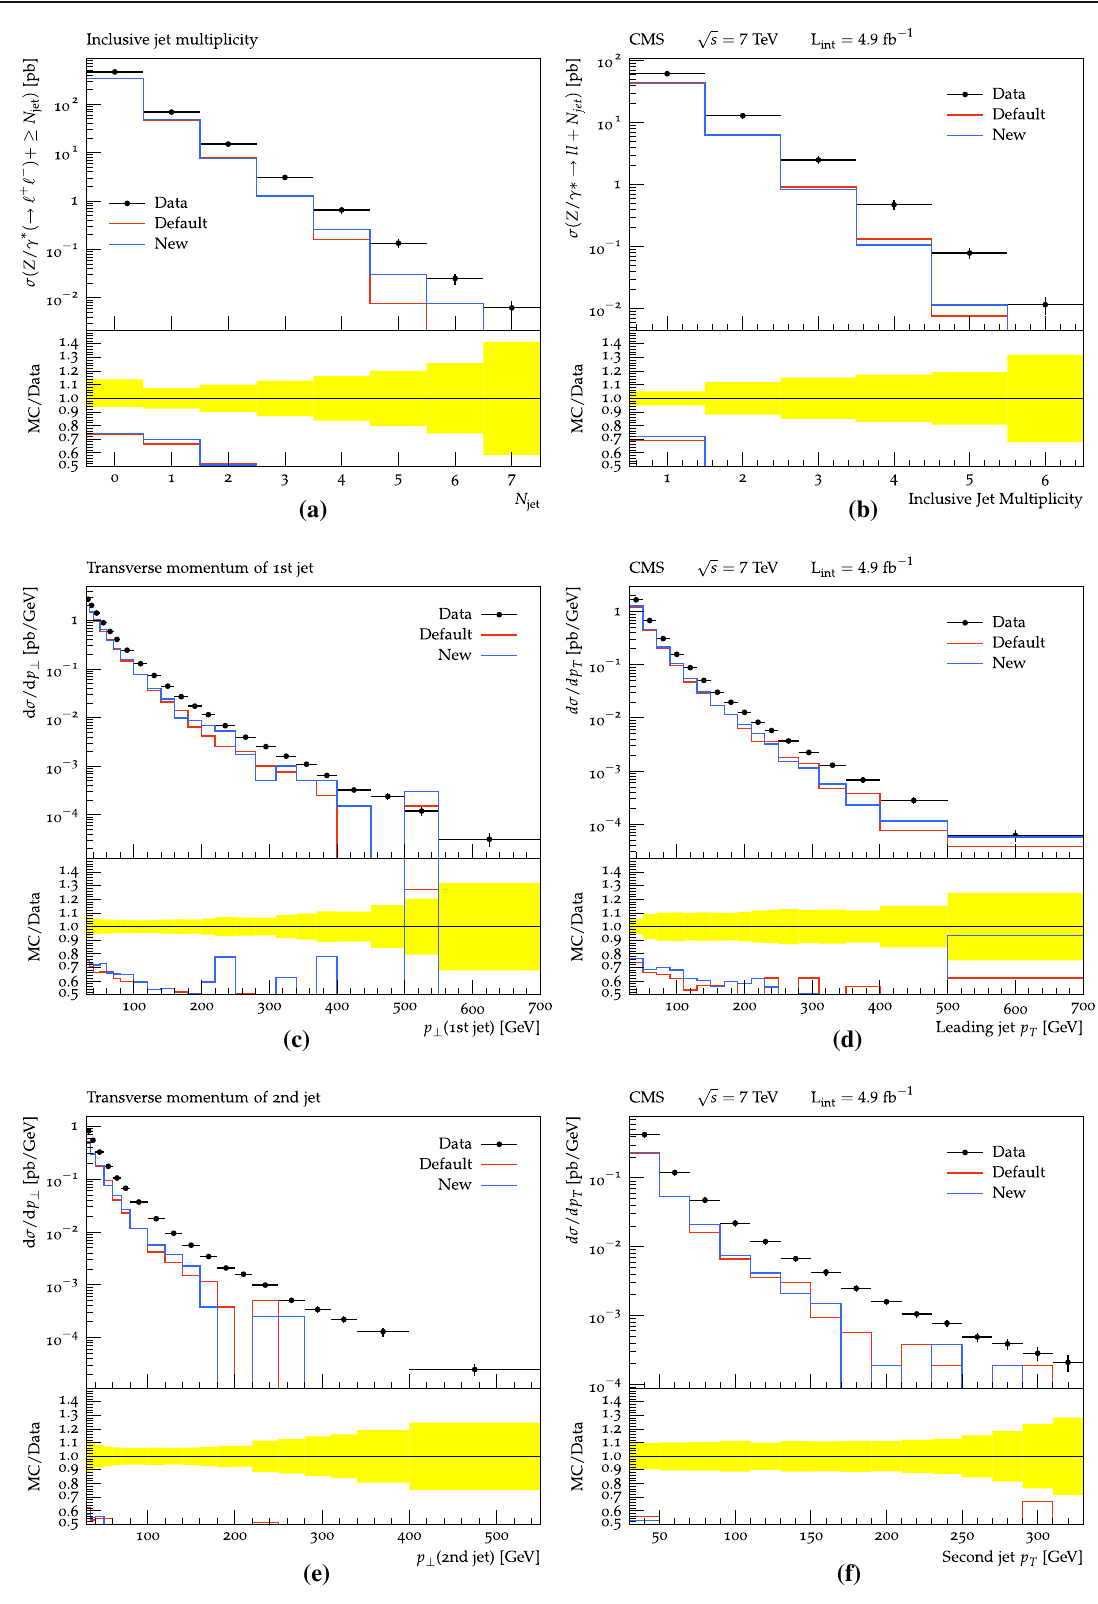
Fig. 12 Jet production in inclusive γ ∗ / Z 0 events, as measured by ATLAS ( a , c , e ) and CMS ( b , d , f ), respectively, for pp collisions at 7 TeV [44,48,49]: a , b the number of jets, c , d p ⊥ of the first jet, e , f p ⊥ of the second